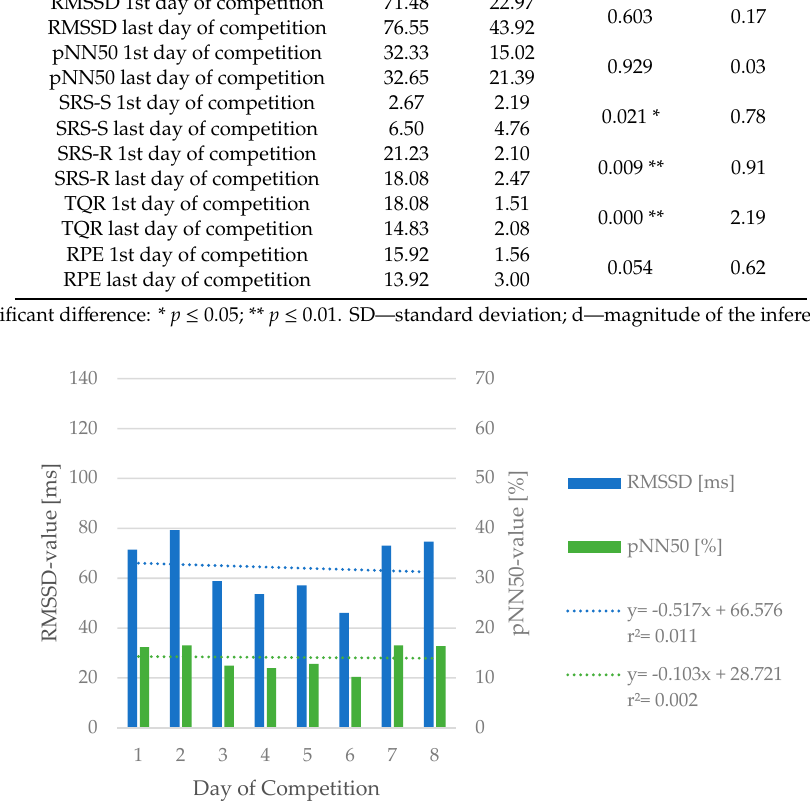
Figure 1. Daily di ff erences for RMSSD and pNN50 over the course of competition. Results are presented Figure 1. Daily differences for RMSSD and pNN50 over the course of competition. Results are as mean ± SD (95% CI) in (ms) for RMSSD and (%) for